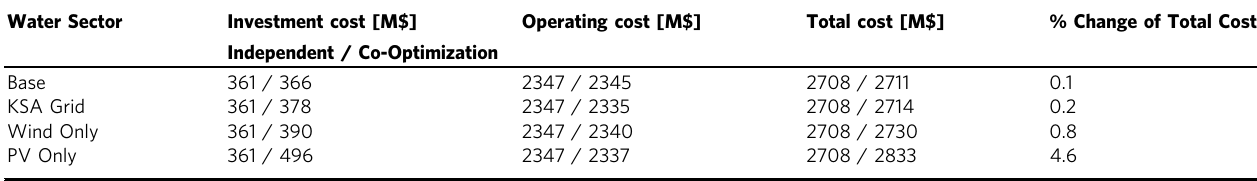
Shown are results for the Base, Kingdom of Saudi Arabia (KSA) Grid, Wind Only, and Photovoltaics (PV) Only cases.